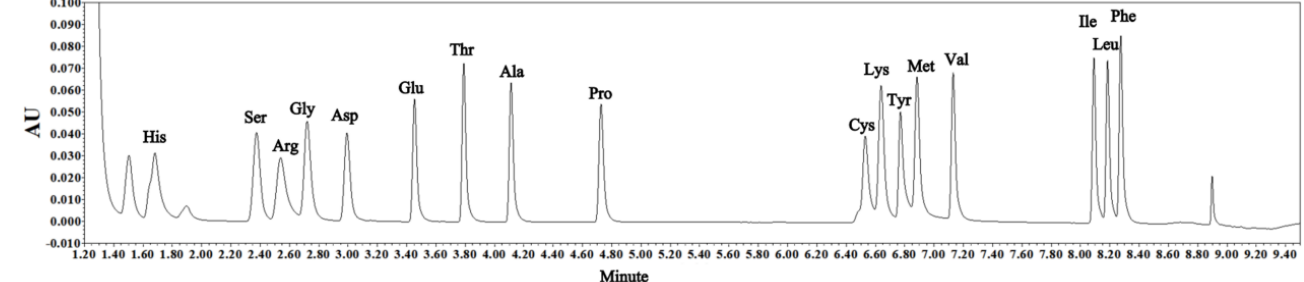
Figure 2. Chromatogram of the standards of amino acids detected by UHPLC.